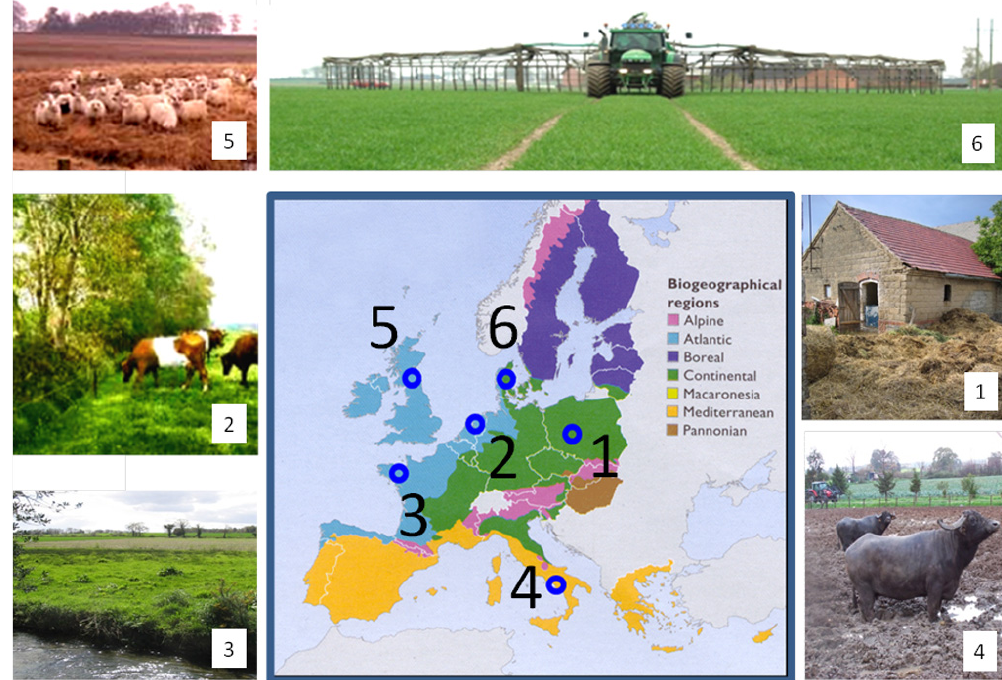
Fig. 1. Location of the six study landscapes: (1) Turew, PL; (2) The North Friesian Woodlands, NL; (3) Naizin, FR; (4) Piana del Sele, IT; (5) Southern Scotland, UK; and (6) Bjerringbro, DK; superimposed onto the European Environmental Agency’s (2002) biogeographical regions of Europe. The photographs show important farming systems in these landscapes (clockwise from bottom left corner, and with number corresponding to the actual landscape): intensive cattle grazing on wet, permanent grasslands in France and the Netherlands, sheep grazing on rough grassland in Scotland, pig slurry application with trailing hose to winter cereals in Denmark, farmyard manure heap outside a traditional farmhouse in Poland, and a water buffalo paddock in Italy.